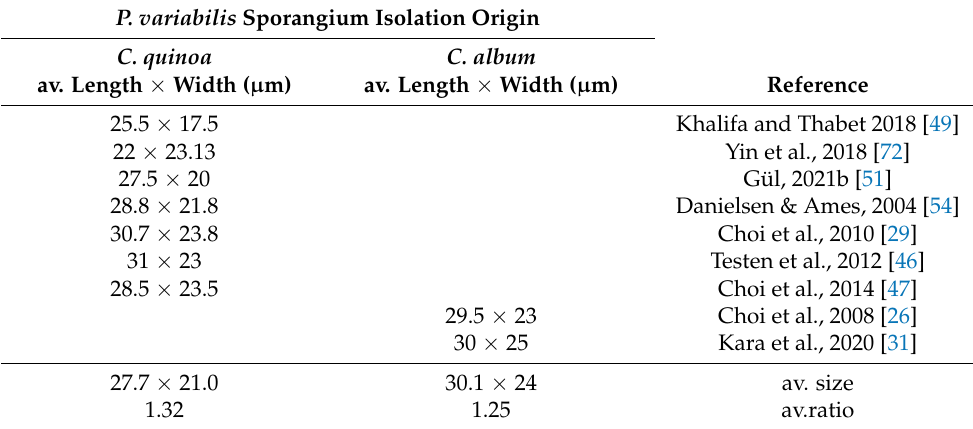
Table 3. Peronospora variabilis sporangium sizes when isolated from C. quinoa and C.